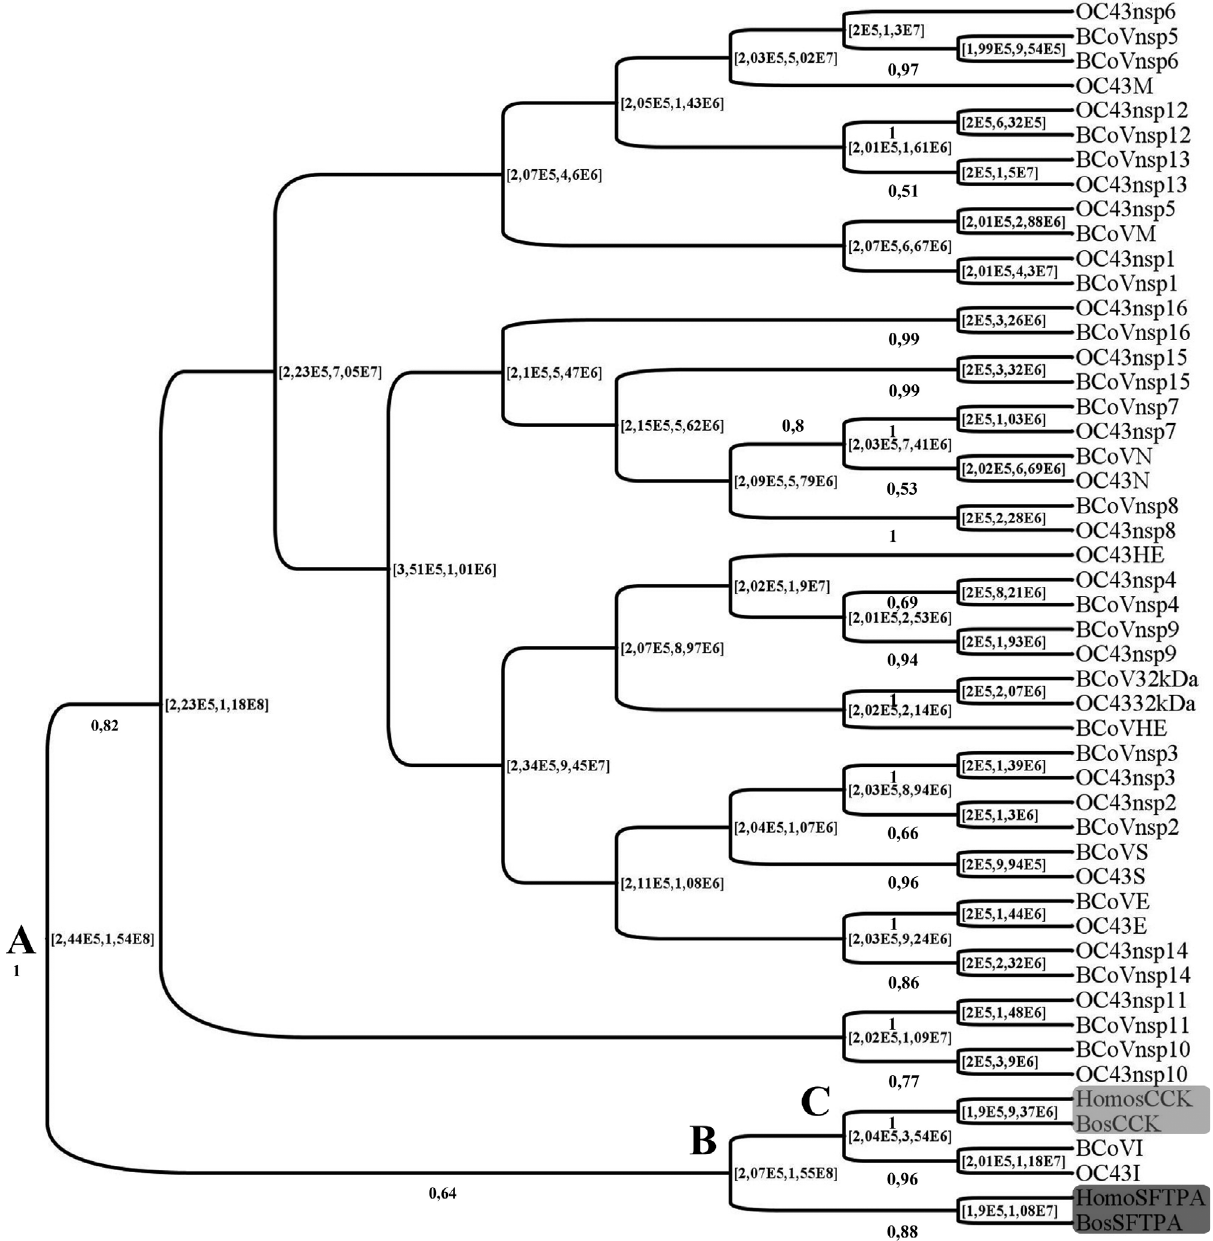
Figure 3 - MCC tree (burn in = 10% states, uncorrelated exponential clock and constant population size) for BCoV and HCoV-OC43 coding re- gions/mRNAsfornsps1-16,ns2andstructuralproteinsHE,S,E,M,IandNandtherepresentatives(mRNAs)ofhumanandbovinehighly-expressed,tis- sue specific proteins CCK (light grey rectangle, cholecystokinin, enteric tract) and SFTPA1 (dark grey rectangle, surfactant protein A1, respiratory tract) based on the respective binary RSCU (Relative synonymous codon usage) values, showing the host/viruses split nodes A, B and C. Values to the left of each node are the posterior probabilities (only values > 50 are shown) and values to the right of each node are the 95% HPD (in years since 2004, the date of the HCoV-OC43 strain 19572